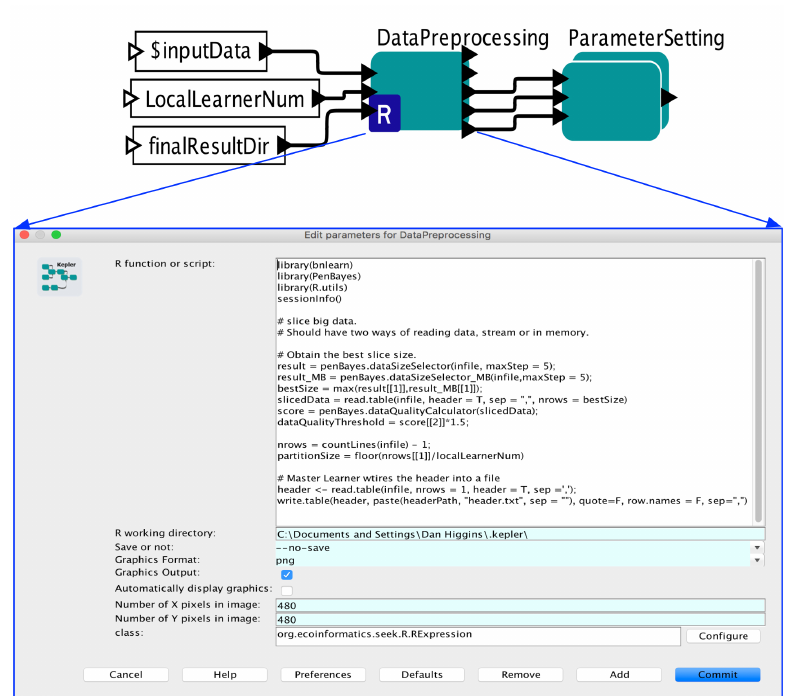
Figure 4. Data Preprocessing Sub-workflow.